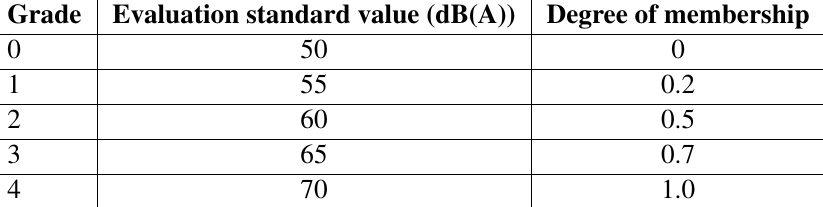
Table 6 Noise evaluation criteria of mangrove reserve (day).